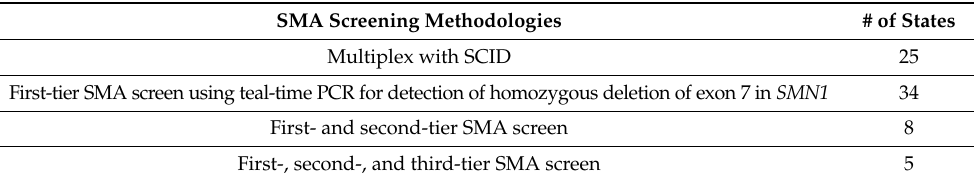
Table 1. Summary of spinal muscular atrophy newborn screening methodologies in the United States, June 2021 (state specific details in Appendix